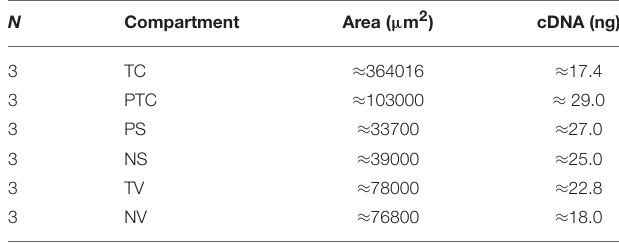
TABLE 2 | cDNA yield after SMARTer protocol.